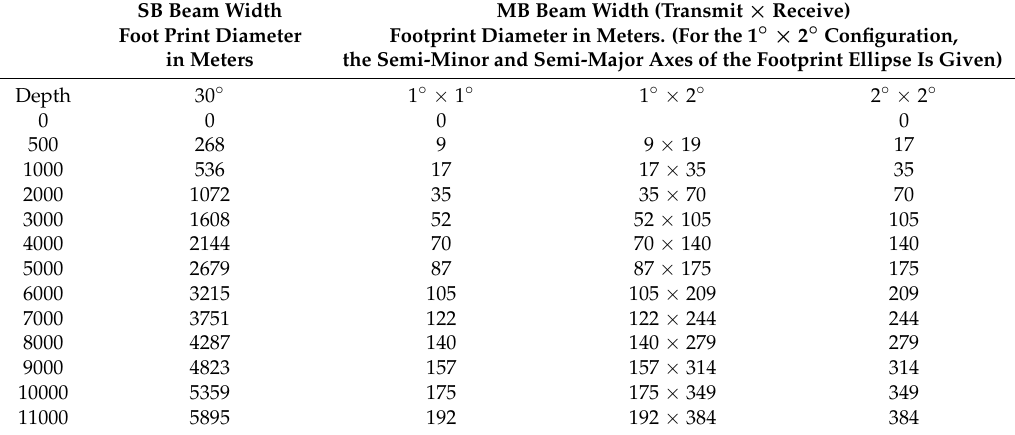
Table 1. Calculated foot prints of ensonified seafloor area at different water depths for single-beam (SB) and multibeam (MB) echo-sounders with various beam